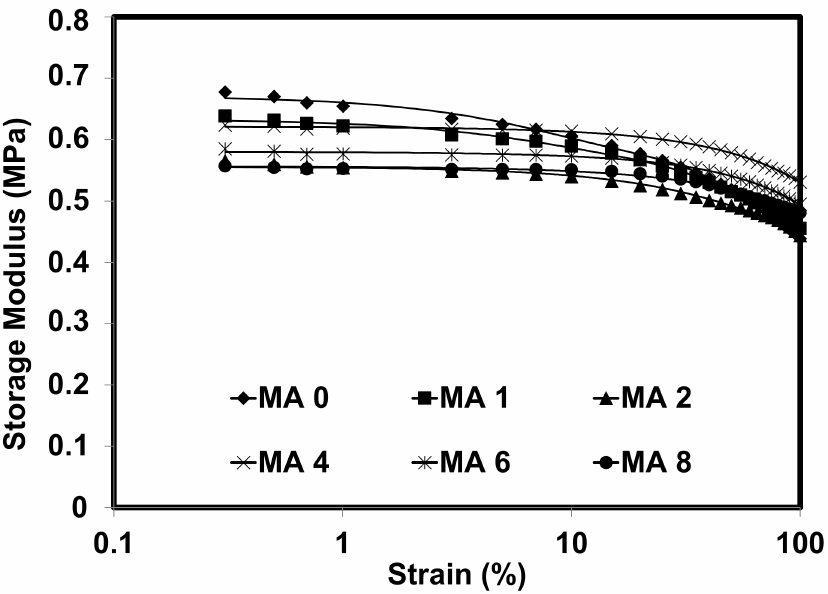
Figure 9. Storage moduli of NR/HNT and MNR/HNT composites.